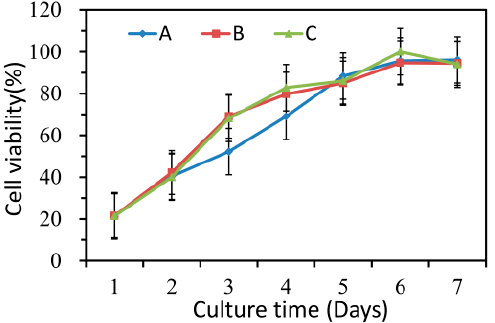
Figure 9. Cell compatibility of electrospinning nanofibers. A: control; B: nanofiber membranes without emodin; C: nanofiber membranes with emodin.